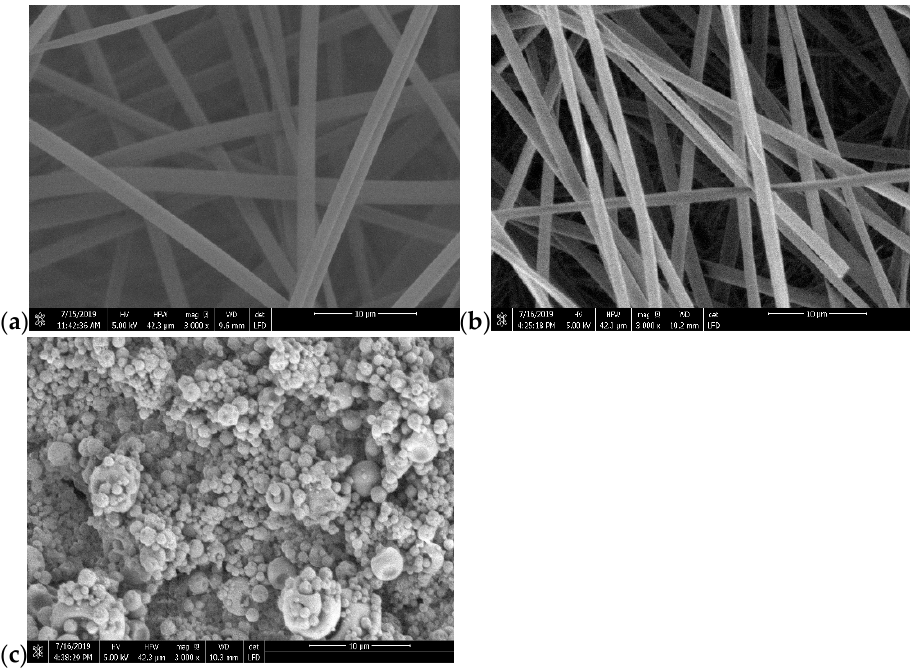
Figure 1. SEM of ( a ) lignin; ( b ) lignin/PAMAM 1wt%; ( c ) lignin/PAMAM 2wt%. The fiber diameters of lignin and lignin/PAMAM were measured before and after thermal-treatment (heat-setting) using SEM, as illustrated in Figure 2. It was noted that the average diameters of the lignin/PAMAM nanofibers in both heat-set and not heat-set samples were less than the pristine lignin nanofibers, due to the reduction of surface